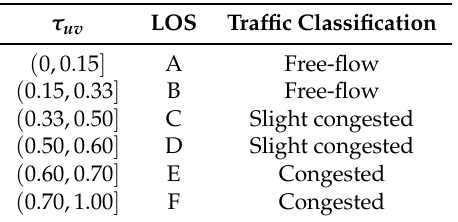
Table 3. Relation of τ uv and its traffic